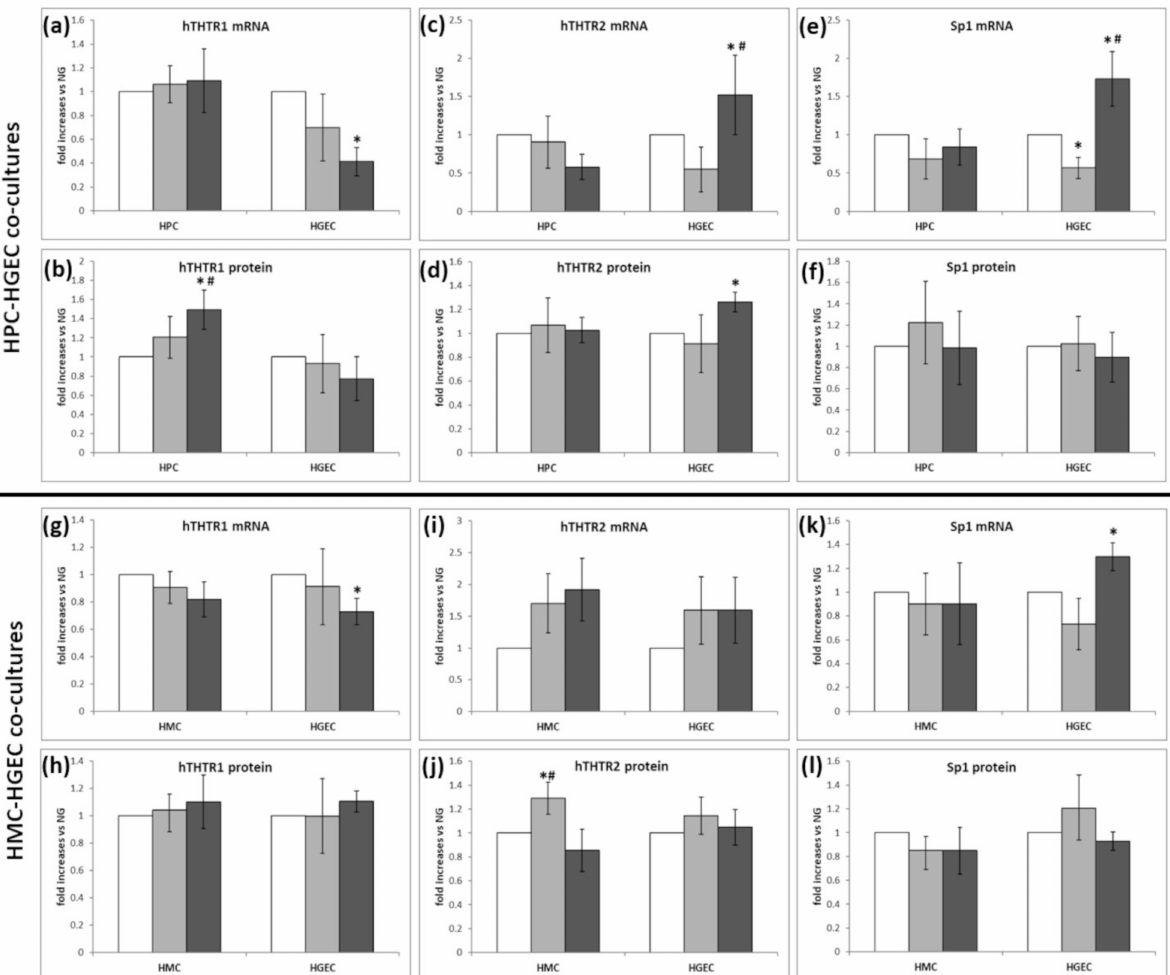
Figure 2. THTR1, THTR2 and Sp1 expression in cocultured renal glomerular cells under different experimental conditions. ( a – f ) HPC–HGEC cocultures, ( g – l ) HMC–HGEC cocultures. ( a , g ) THTR1 mRNA and ( b , h ) protein expression; ( c , i ) THTR2 mRNA and ( d , j ) protein expression; ( e , k ) Sp1 mRNA and ( f , l ) protein expression. White bars: physiological glucose concentrations (NG); light grey bars: high glucose concentrations (HG); dark grey bars: intermittent high glucose conditions (intHG). NG = physiological glucose concentrations; HG = high glucose concentrations; intHG = intermittent high glucose concentrations. Mean of 5 experiments ± SD. * p < 0.05 vs. NG; # p < 0.05 vs.